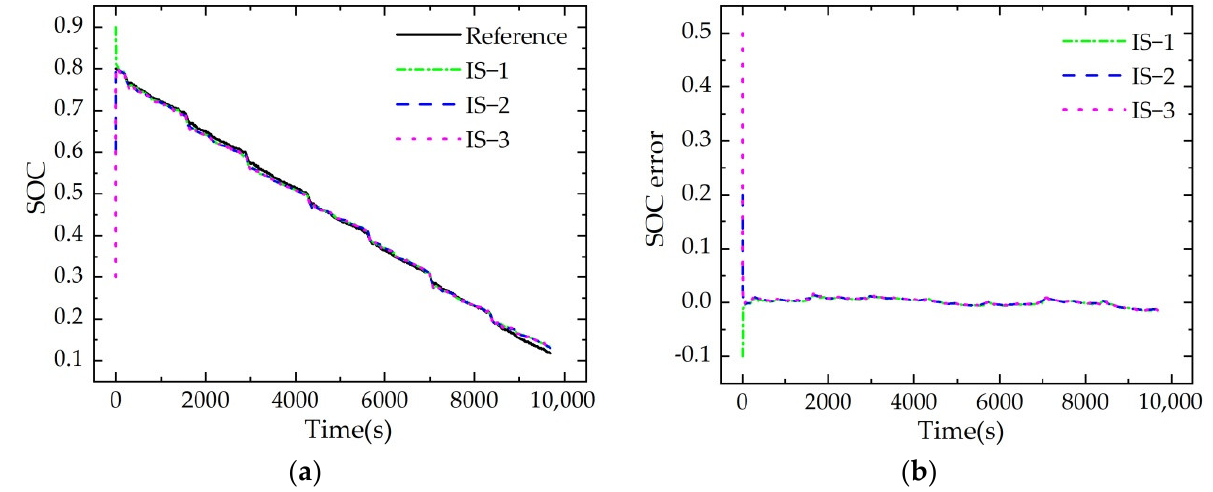
Figure 14. SOC estimation results in three cases under the FUDS test: ( a ) SOC estimation results; ( b ) SOC error.